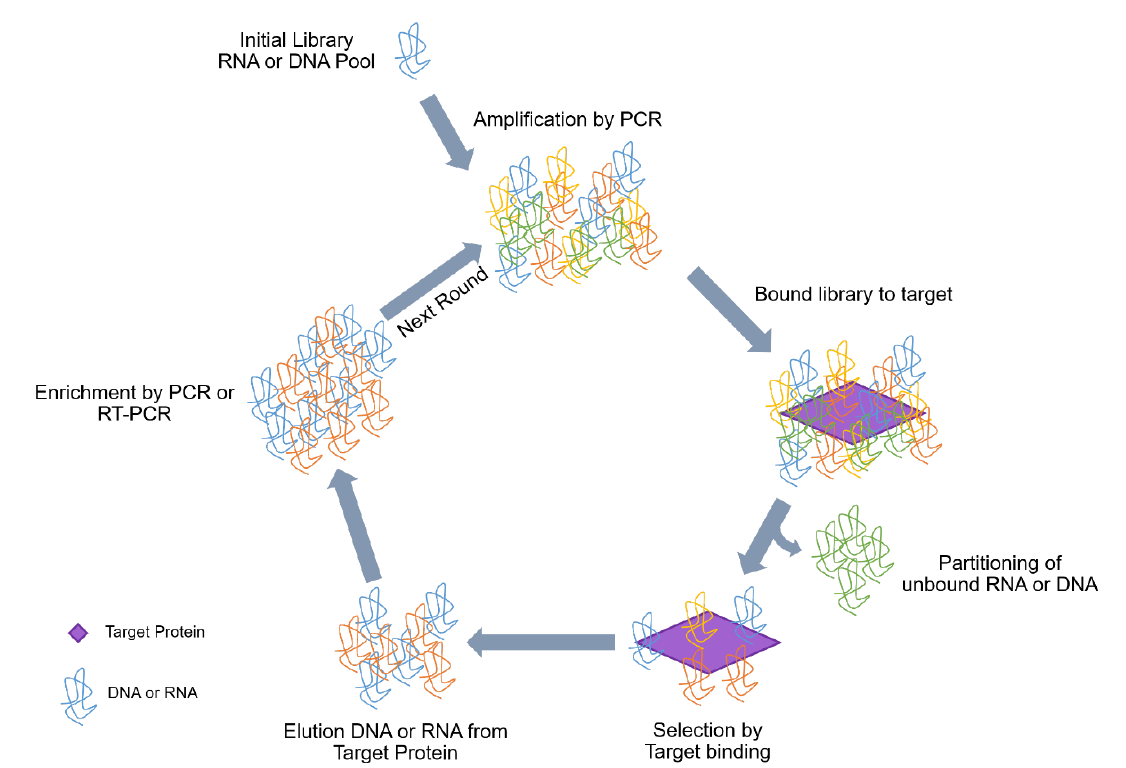
Figure 1. Scheme of the general systematic evolution of ligands by exponential enrichment (SELEX) procedure. The SELEX procedure is a repeated process as follows. (1) incubate library with target; (2) remove unbound oligonucleotides; (3) Elute target binding oligonucleotides; (4) enrichment by polymerase chain reaction (PCR) or reverse transcription-polymerase chain reaction (RT-PCR).